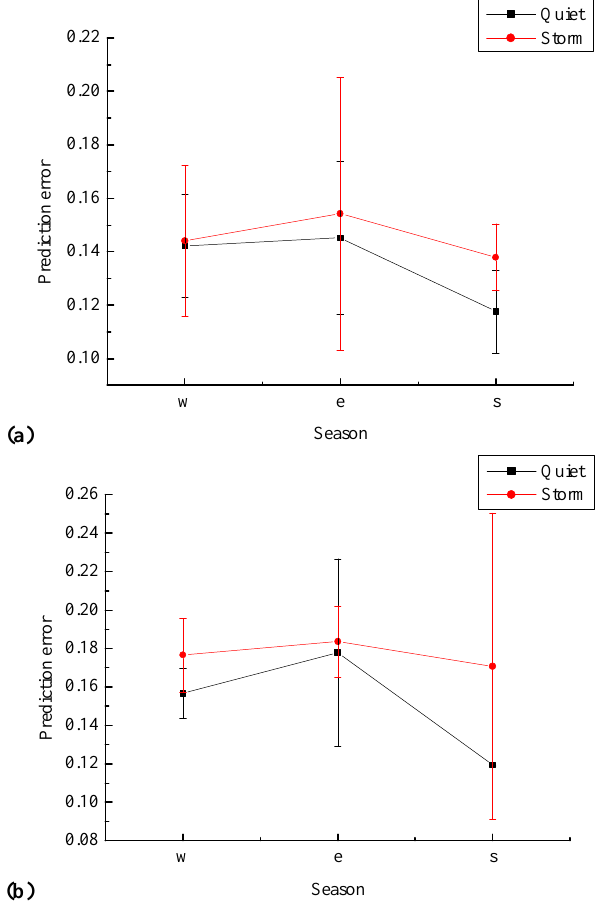
Figure 6b Fig. 6. Comparison of seasonal mean values of nonlinear predic- tion error for AE index time series for summer, equinox and winter (denoted by letters, “s”, “e”, and “w”, respectively on x-axis), dur- ing storm and quiet periods (red and black lines respectively) of (a) high (1991) and (b) low (1994) solar activity years. The vertical bars represent the standard deviation (red for storm and black for quiet